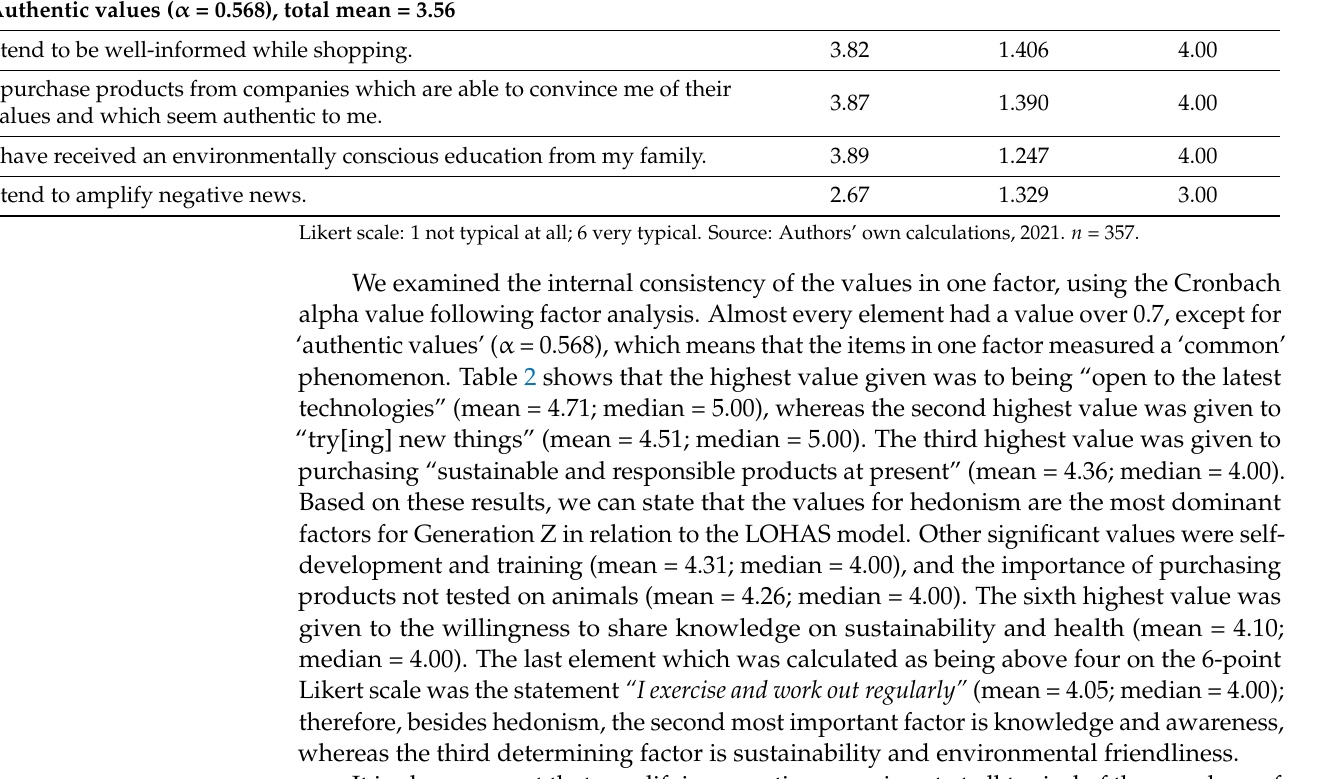
Table 2. Cont. Scale Elements Mean